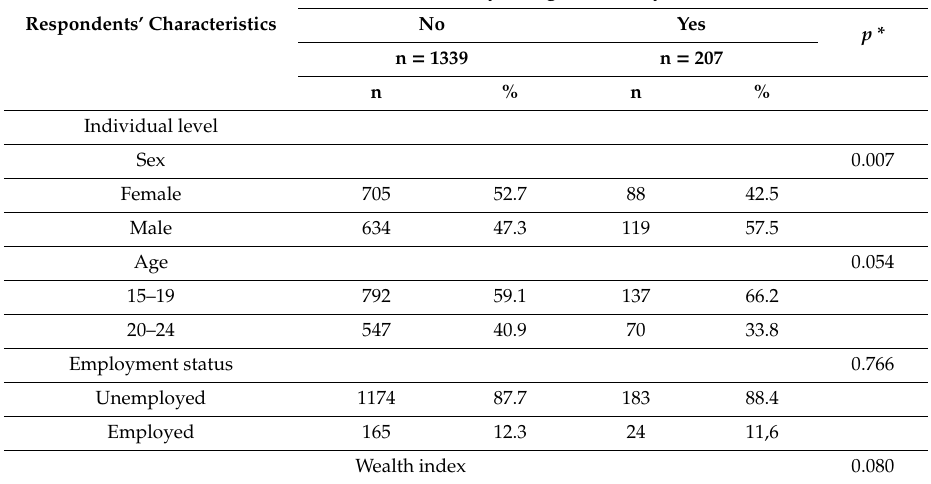
Table 1. Distribution of respondents according to combined (psychological and physical) violence victimization regardless to their demographic and other characteristics, young people in Serbia age 15–24 years (n = 1546),